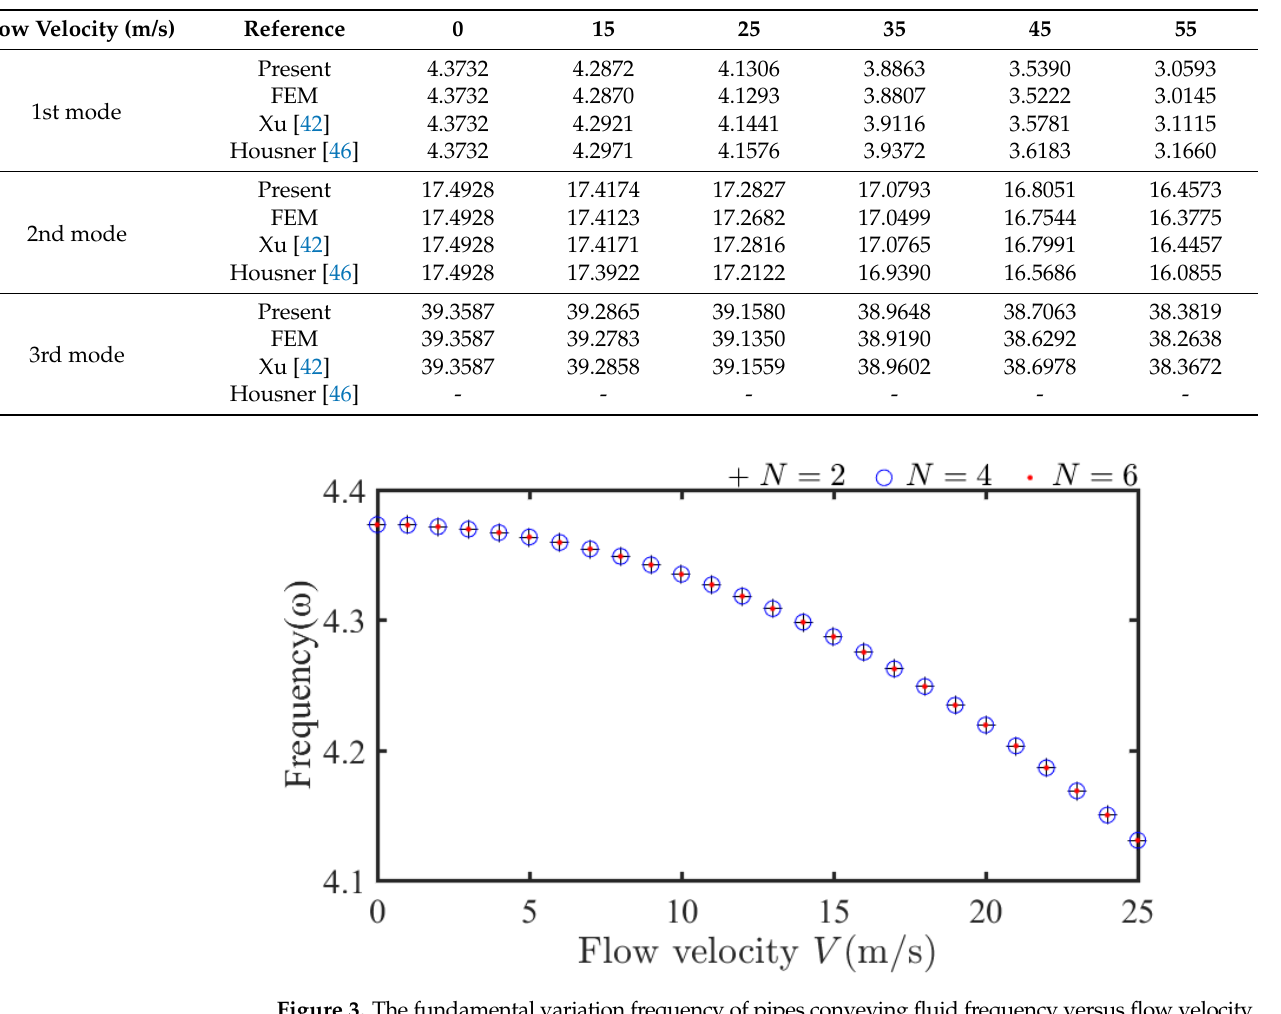
Figure 4. Time history diagram of GPLRC pipes conveying fluid with a uniform disribuiton of GPLs. Figure 5 indicates a higher frequency and lower amplitude of vibrations, because the structural stiffness is increased by the addition of GPLs. However, the amplitude difference of the GPLRC pipes conveying fluid under three distribution modes is not significant. This is because the pipes conveying fluid are slender hollow beam structures with thin thickness. The results imply that in an actual industrial production process, any GPL distribution can be selected for structure production according to convenience. In the follow ‐ up study, the GPL ‐ X distribution is selected for research and discussion.